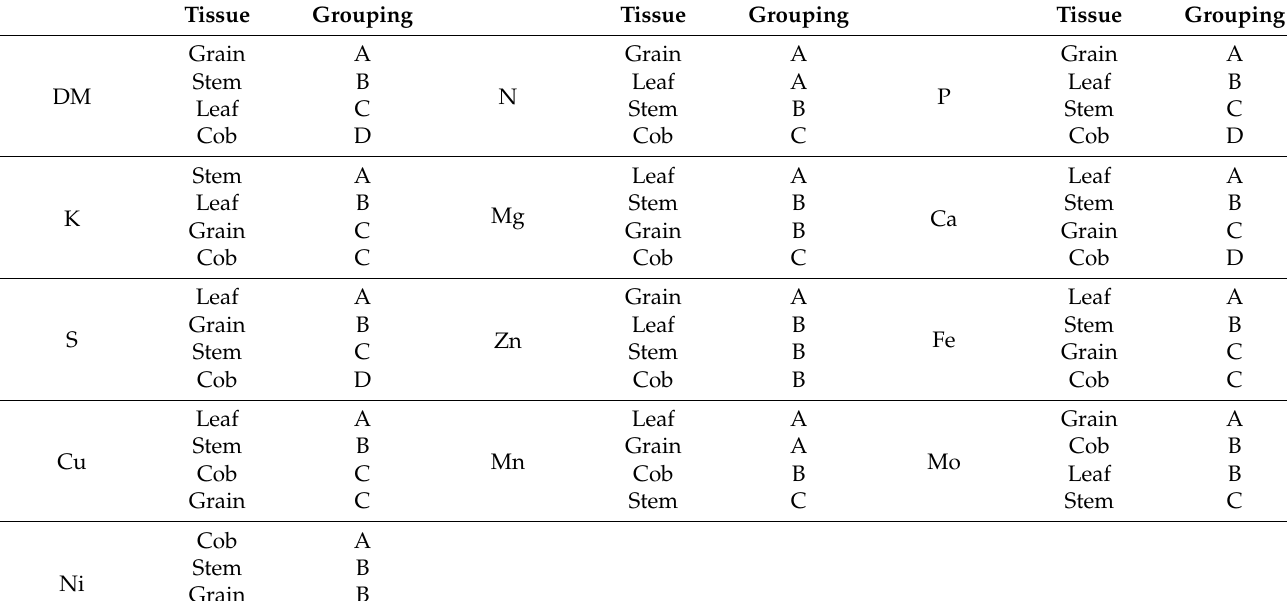
Table 2. Grouping based on Tukey analysis of different parts of